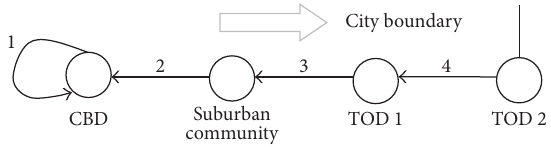
Figure 2: A small test